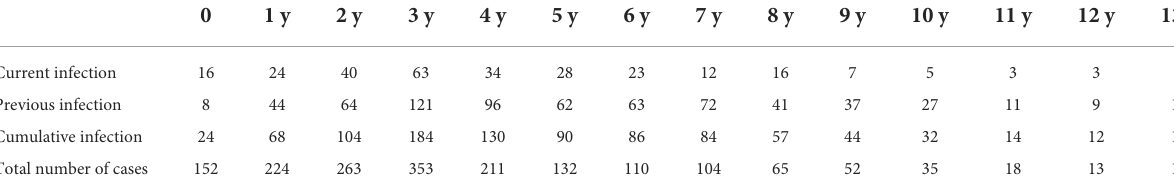
TABLE 1 Age distribution of all participants.